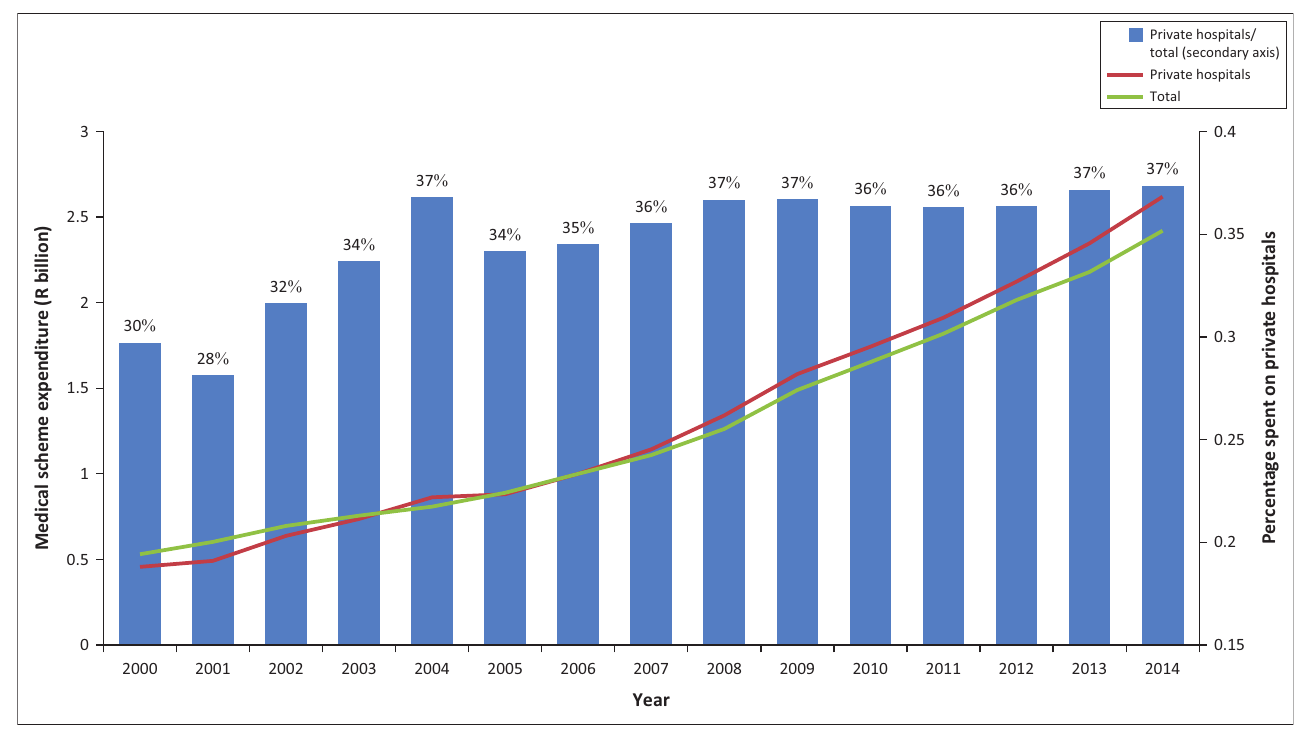
FIGURE 1: Indexed (to 2006) nominal (Rands) total medical scheme expenditure and the portion spent on private hospitals,